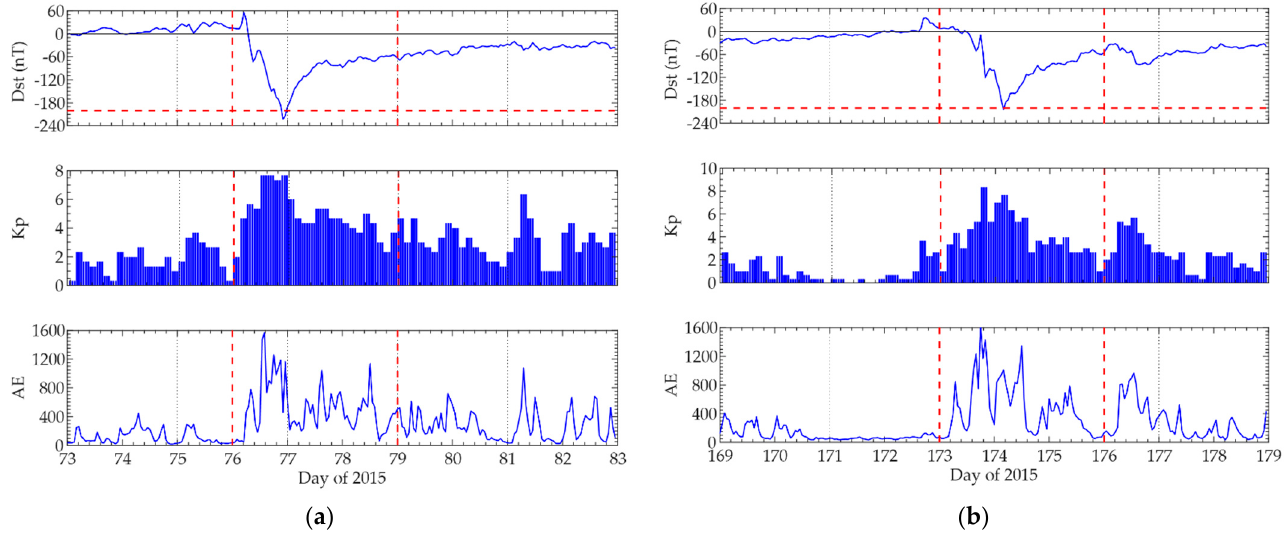
Figure 7. Variation of Dst, Kp, and AE index during the geomagnetic storm period of ( a ) days 73–83 in 2015; ( b ) days 169–179 in 2015. The variation of the magnetic Dst index during this storm is shown on the top panel, the red dash lines in horizontal indicate the Dst at the level of − 200 nT, and the vertical red dash lines indicate the storm periods. Figure 8 is the same format as Figure 6 but during geomagnetic storm conditions.